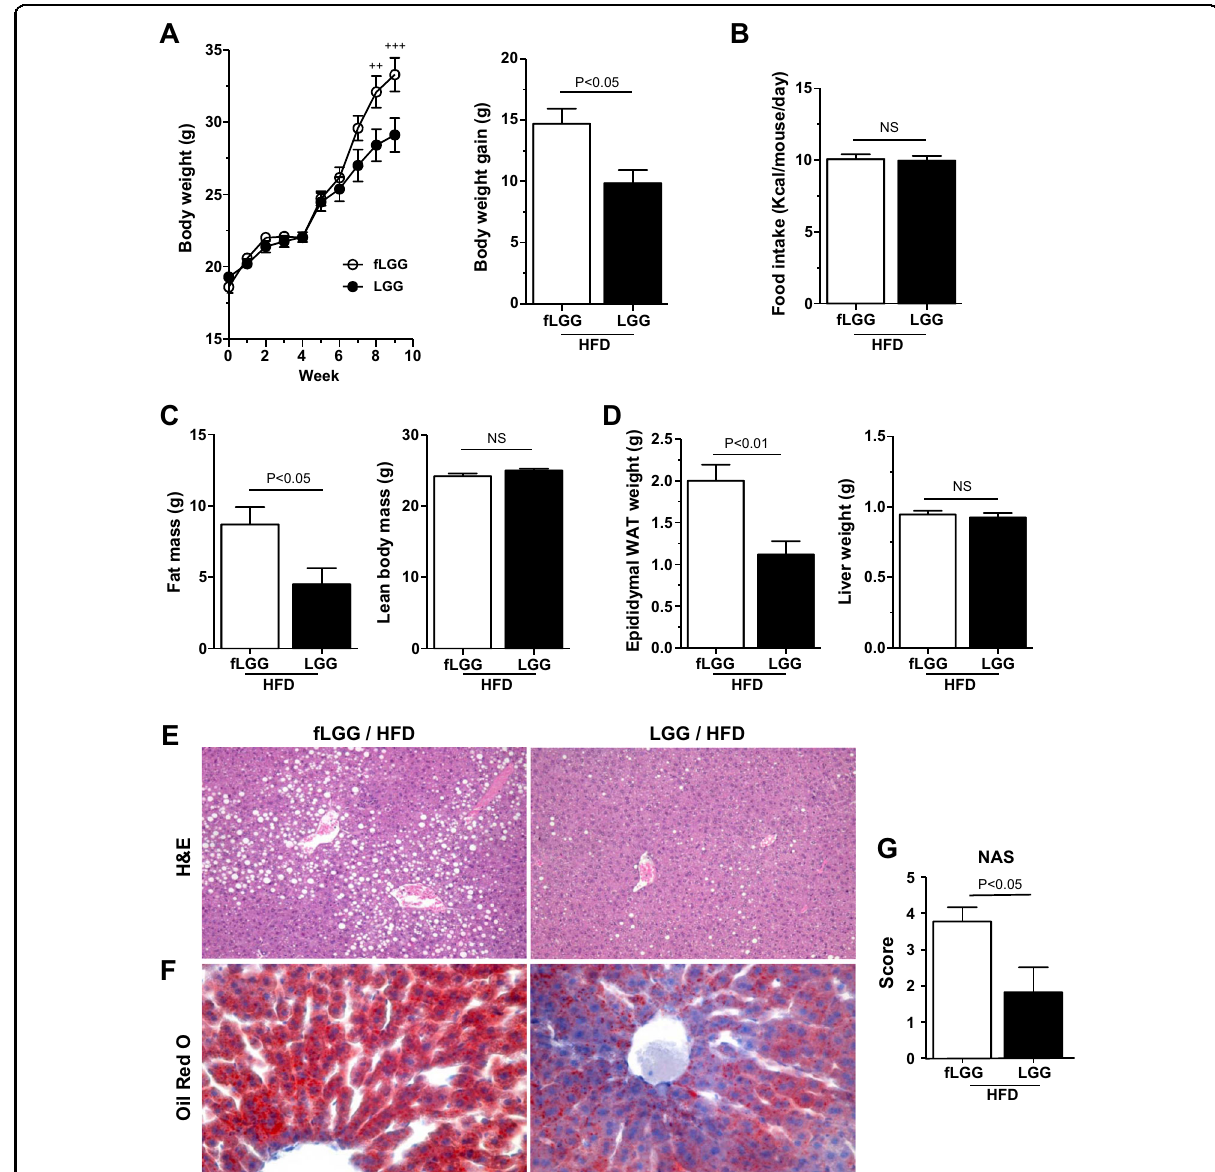
Fig. 3 In vivo, body weight gain and fat mass are decreased in the LGG group during long-term HFD study. a Left panel: body weight change curve during experimental periods; right panel: body weight gain. b Food intake. c Body composition. The left panel is the fat mass, and the right panel is the lean body mass. d Tissue weight. The left panel is the epididymal white adipose tissue (WAT) weight, and the right panel is the liver tissue weight. e Hematoxylin and eosin staining and f Oil Red O staining of liver sections (original magni fi cation ×20). g NAFLD activity score (NAS). Data are expressed as the mean ± SEM ( n = 5 – 6 per group). ++ P < 0.01 and +++ P < 0.001 by two-way ANOVA with post hoc analysis. Statistical